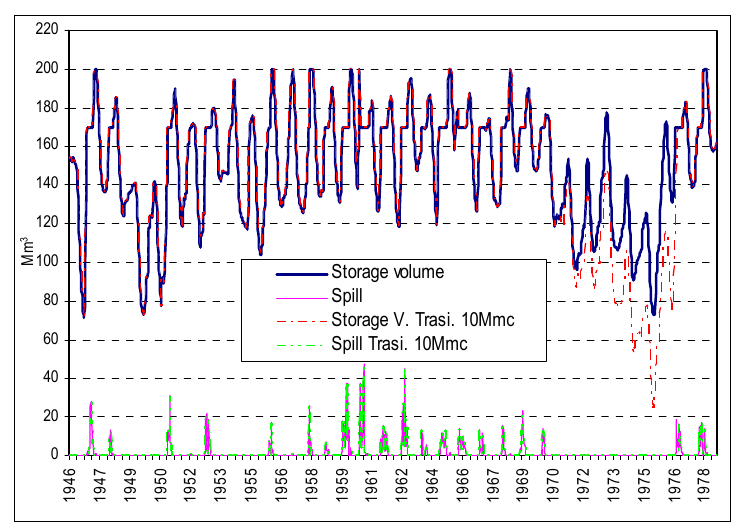
Figure 6. S. Lucia control node, discharge and MIF in scenario n.1.